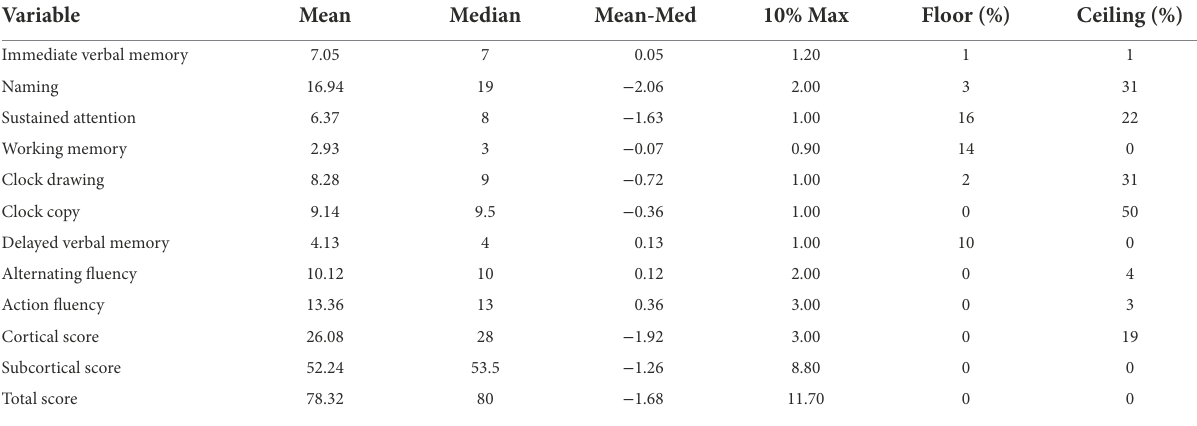
TABLE 2 Acceptability of the PD-CRS tests, sub-scores, and total score. Variable Mean